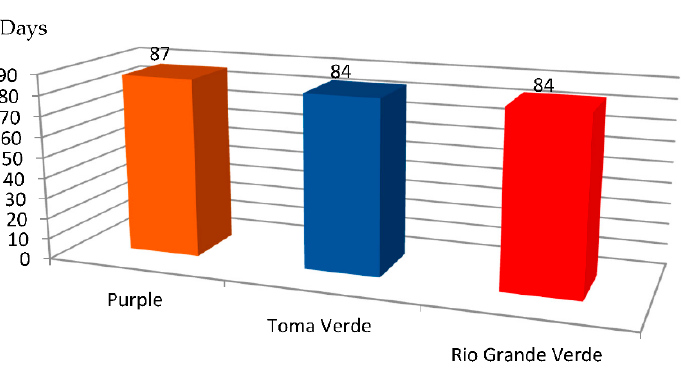
Figure 5. The effects of cultivar, plant covers and soil mulching on the number of days between transplanting seedlings to the first harvest of tomatillo fruit) (means of 2015, 2017–2018).